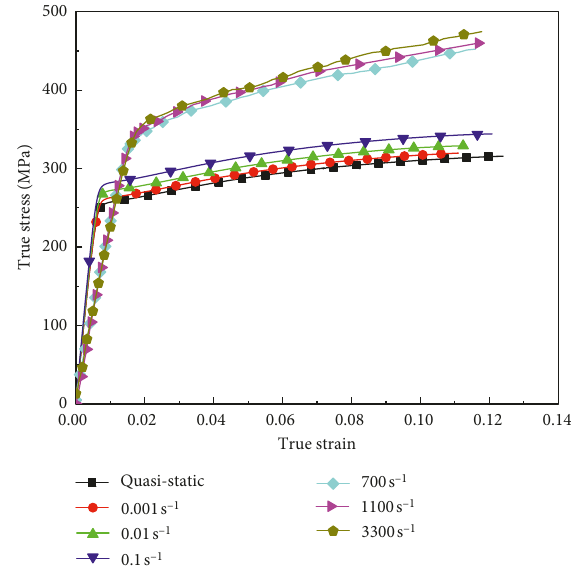
Figure 4: True strain-stress curves of 6005 Al alloy at different strain